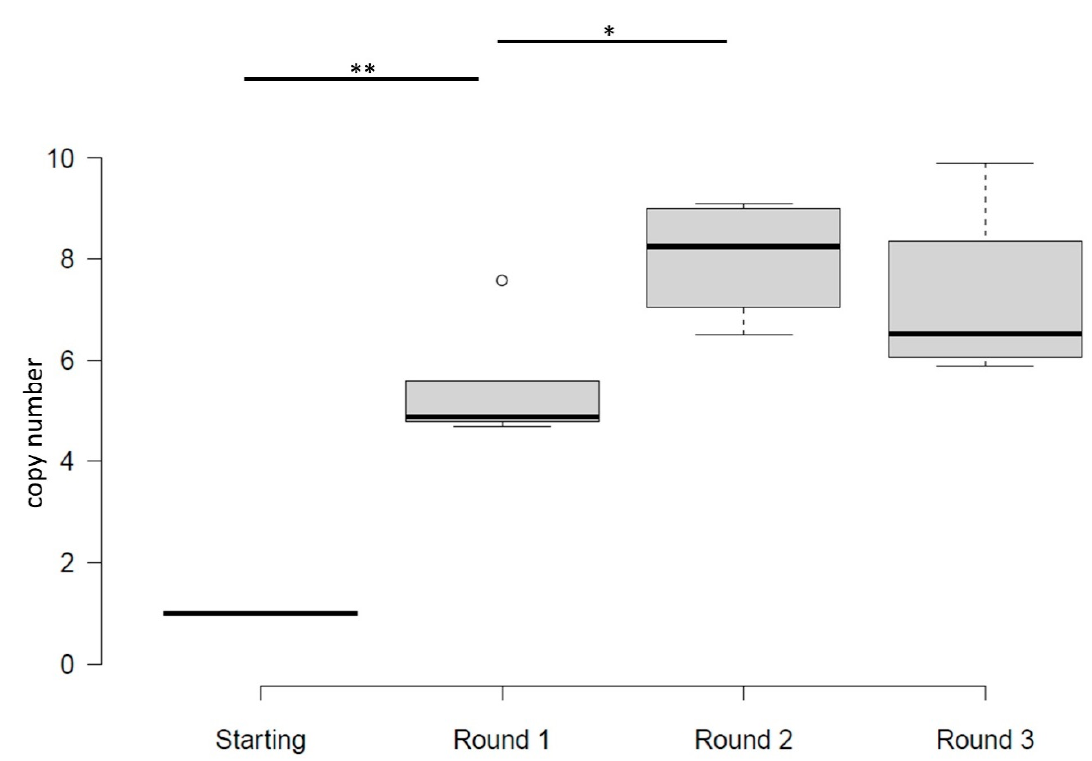
Figure 6. Copy numbers of the SpR gene of E. coli BLK16_IS 3 :: vioABCDE _SpR detected by ddPCR after 1, 2 or 3 rounds of IS 3 transposase induction. Center lines show the medians; box limits indicate the 25th and 75th percentiles as determined by R software; whiskers extend 1.5 times the interquartile range from the 25th and 75th percentiles, and outliers are represented by dots. n = 1, 5, 4, 4 sample points. * p < 0.05 with two-tailed, unpaired t -test; ** p < 0.002 with two-tailed, one sample t -test.